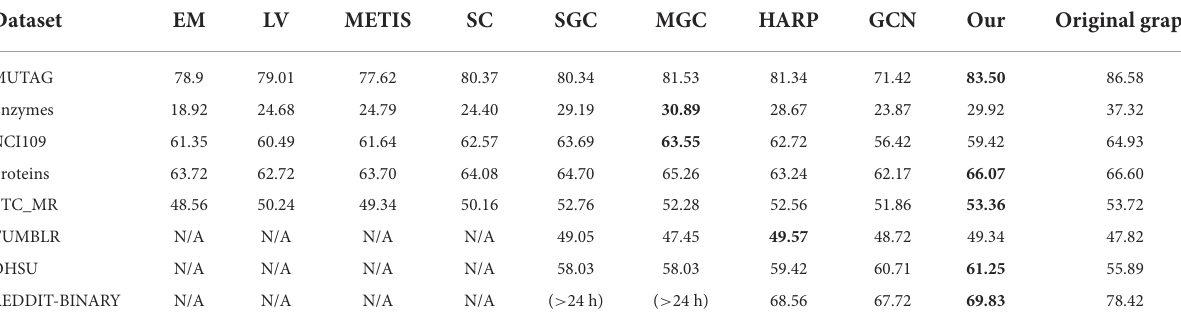
TABLE 5 Average graph classification accuracy for the coarsened graph.